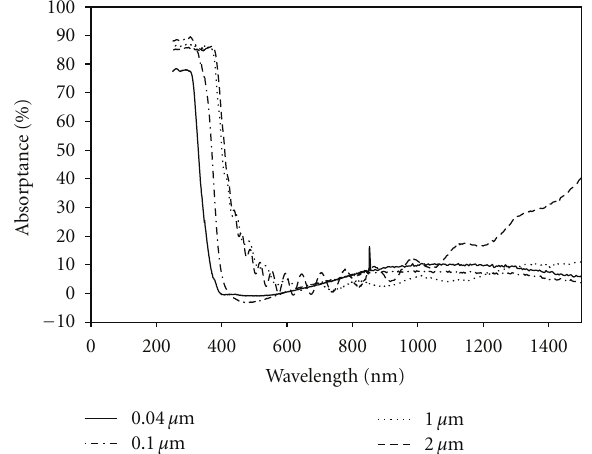
Figure 8: Absorption coe ffi cient calculated data for the above ZnO:Al 2 O 3